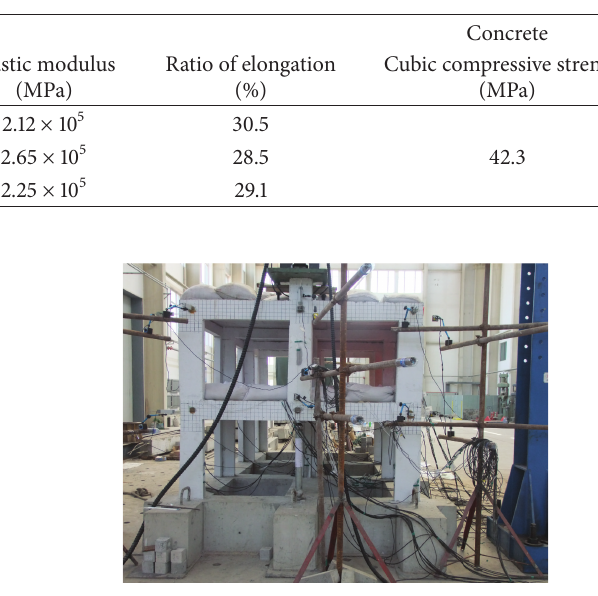
Figure 4: View of experimental model